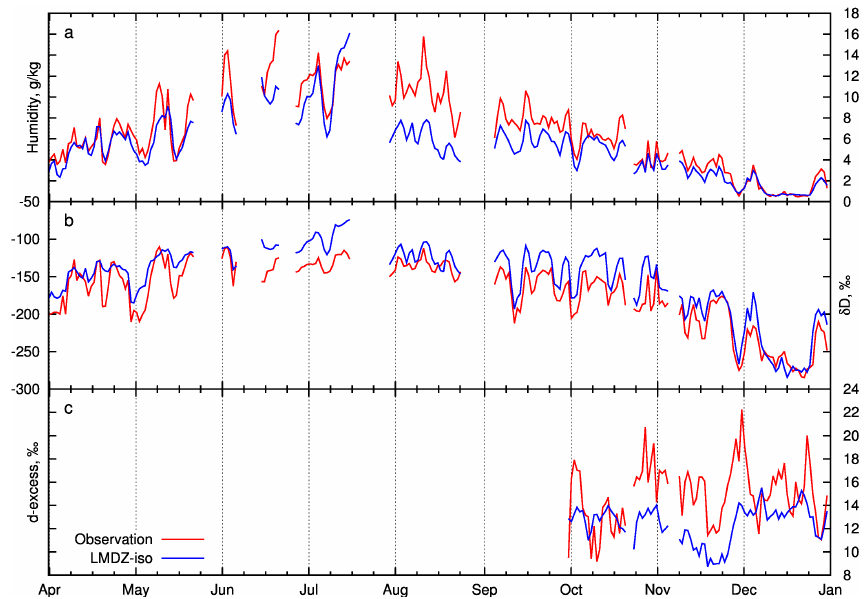
Figure 9. Daily mean time series of humidity (a) , water vapor δD (b) and d excess (c) for observations in Kourovka (red) and simulated by Fig. 9. Daily mean time series of humidity (a), water vapor δD (b) and d-excess (c) for observations in LMDZ (blue). Kourovka (red) and simulated by LMDZ (blue).